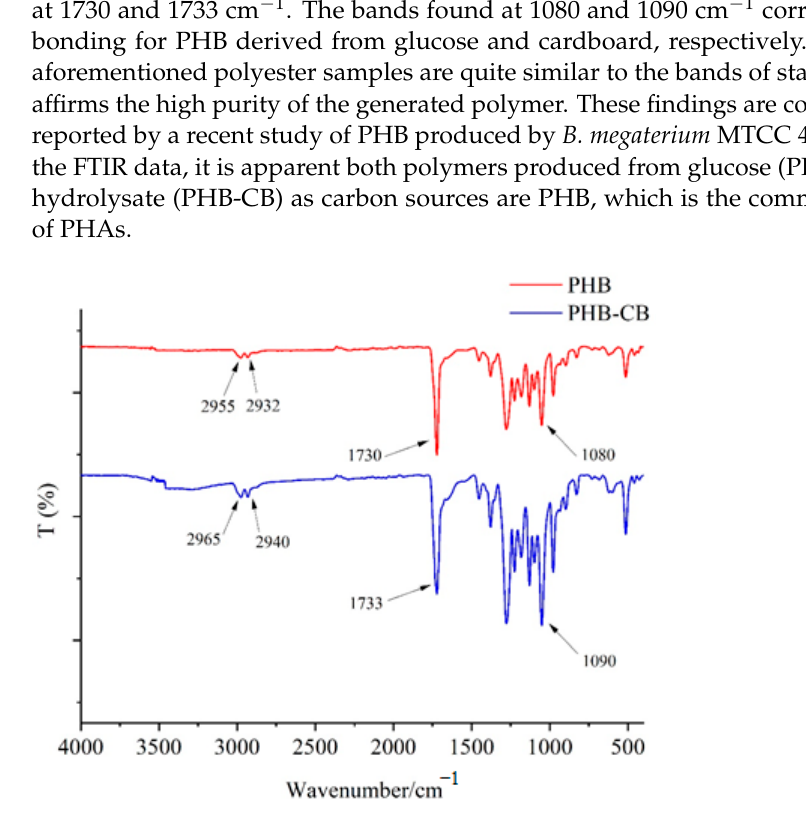
Figure 4. FTIR spectra of polymers isolated from B. mycoides ICRI89 grown in MSM containing either glucose (PHB) or cardboard hydrolysate (PHB-CB) as carbon sources.